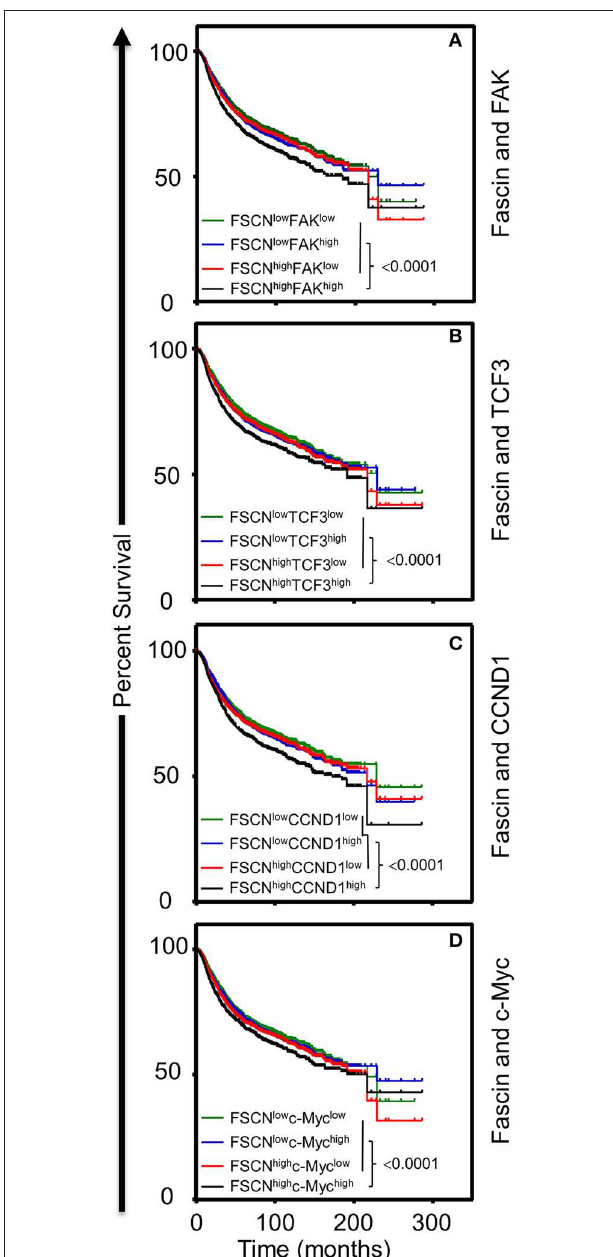
FIGURE 6 | (A–D) Coexpression of fascin high in conjunction with FAK high and high β -catenin downstream targets correlates with poor breast cancer survival. Kaplan–Meier plot showing recurrence-free survival (RFS; n = 3,951) of TCGA breast cancer cohort for (A) fascin and FAK, (B) fascin and TCF3, (C) fascin and CCND1, (D) fascin and c-Myc. Patients were grouped into high or low based on the respective gene expression, and significance between expression groups was calculated using the log-rank test. P -values are indicated on each plot.